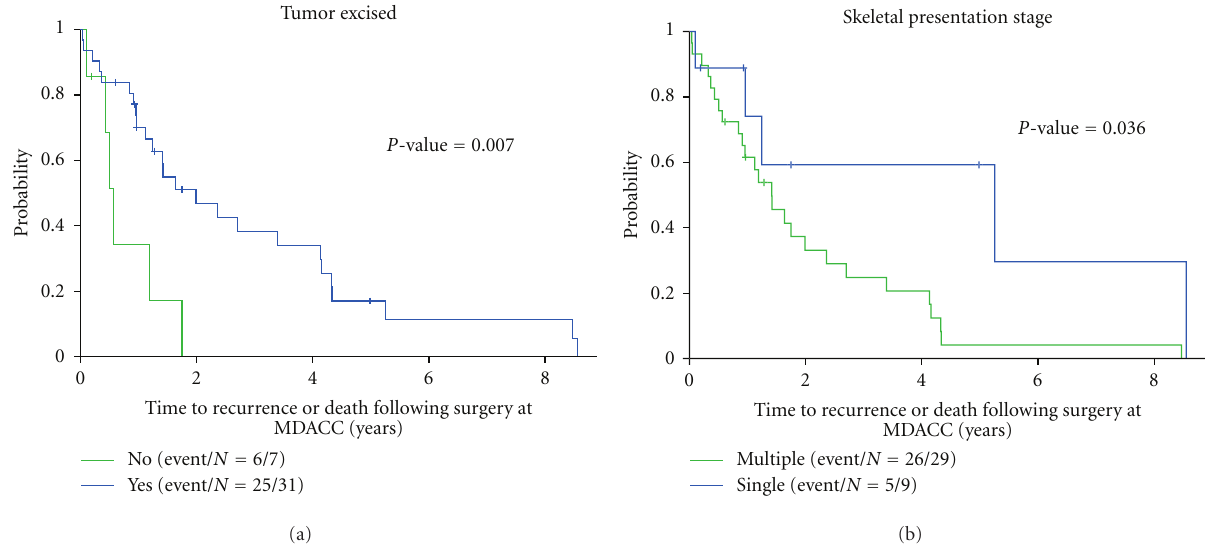
Figure 4: Kaplan-Meier analysis for recurrence free survival, as determined by the probability of no recurrence or death. (a) Patients had a higher probability of recurrence free survival if the osseous metastasis was excised versus no excision ( P = 0 . 007). All patients that had surgeries where the metastasis were not excised died ( n = 6) or were lost to followup ( n = 1). (b) Patients had a higher probability of recurrence free survival if they presented with a single bone metastasis versus multiple bones ( P = 0 . 036). Five of the 9 (56%) patients with single bone metastasis at presentation were alive at last followup, compared with 6 of 29 (21%) patients who presented with multiple bone metastasis.